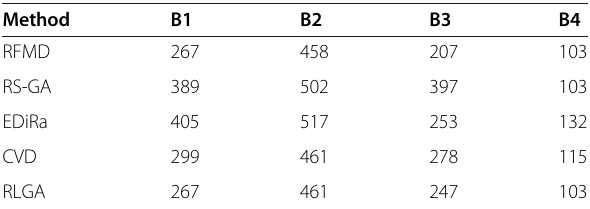
Table 3 Number of discrete intervals in each band of GF-2